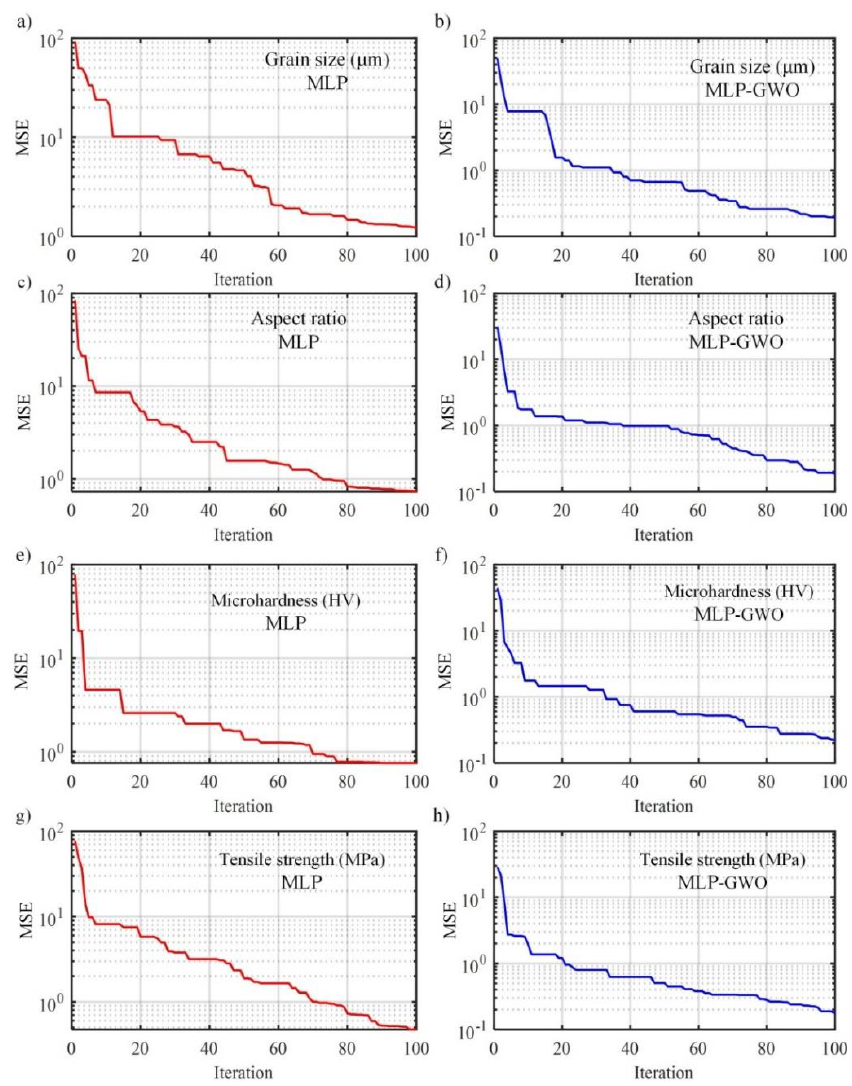
Figure 10. Convergence plots of MLP and MLP-GWO models. ( a ) grain size (MLP); ( b ) grain size (MLP-GWO); ( c ) aspect ratio (MLP); ( d ) aspect ratio (MLP-GWO); ( e ) micro-hardness (MLP); ( f ) micro-hardness (MLP-GWO); ( g ) tensile strength (MLP); ( h ) tensile strength (MLP-GWO).